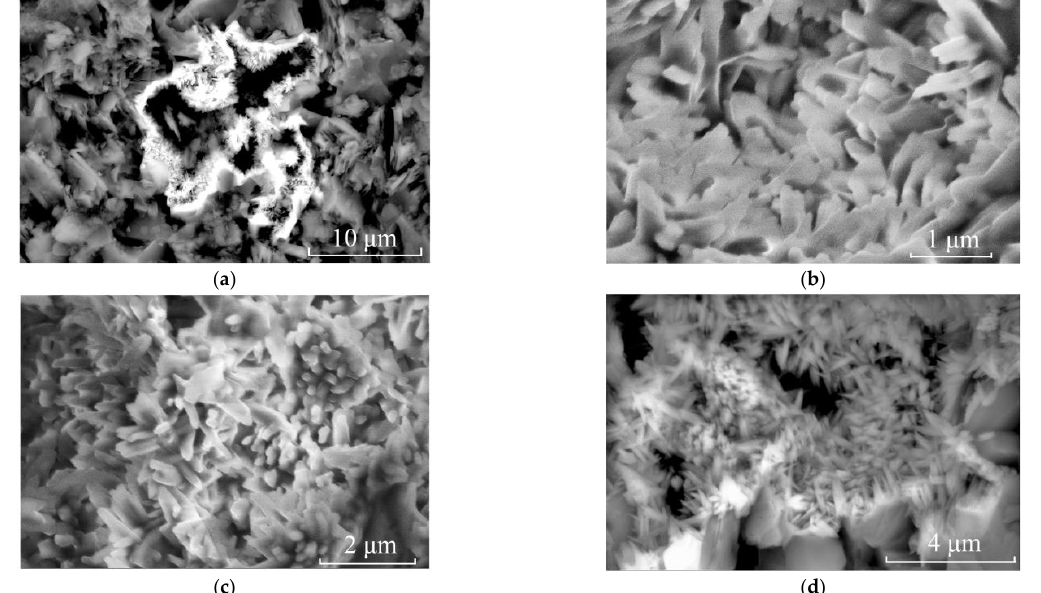
Figure 5. SEM images of clustered acicular minerals in sample LWB-1. ( a ) SEM image of clustered accicular minerals in the void of dickite particles (3500×); ( b ) Zooming image of ( a ) showing thin accicular and rod-like minerals (25,000×); ( c ) Zooming image of ( a ) showing needle-like minerals (10,000×); ( d ) Zooming image of ( a ) showing rod-like minerals (10,000×).